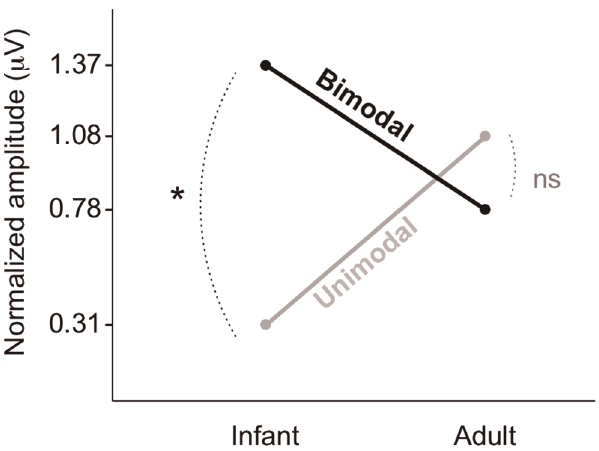
Figure 4. The interaction between Age Group and Distribution Type. Age group: infant, left vs. adult, right. Distribution Type: unimodal, grey vs. bimodal, black.